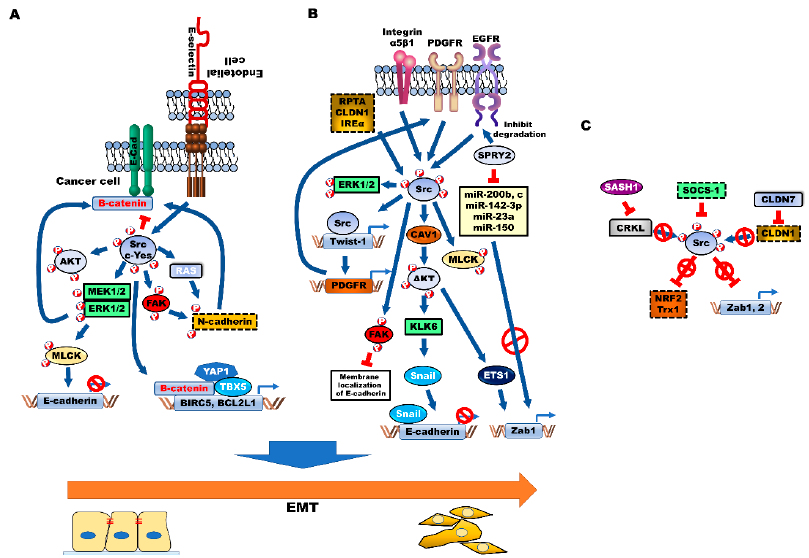
Figure 3. Src activation enhances aggressiveness, chemoresistance and acquisition of cancer stem cell (CSC) properties of colorectal cancer (CRC) by inducing epithelial-to-mesenchymal transition (EMT). Src family kinase (SFK) ( A ) and several cellular processes, such as Src activator ( B )-mediated activation of AKT, MAPK/ERK and FAK, promote EMT by downregulating E-cadherin and inducing β -catenin-dependent malignant processes and N-cadherin expression, through induction of EMT- associated transcriptional factors, such as Twist-1, Snail and Zab1. ( C ) SOCS-1 inhibits EMT through the induction of NRF2 and Trx1 by inhibiting Src. Additionally, CLDN7-mediated inhibition of CLDN1 and SASH1-mediated inhibition of CRKL suppress Src activation and inhibit EMT. ERK/MAP kinase and its direct substrate, myosin light chain kinase (MLCK), which are downstream targets of Src, are required for Src-mediated EMT induction through the formation of integrin adhesion complexes. The Src SH2 and SH3 domains promote the mesenchymal-like phenotype, by upregulating the expression of vimentin and MLC, and downregulating the expression of E-cadherin [131]. E-selectin, an adhesion receptor of endothelial cells, interacts with CRC cells and promotes extravasation of CRC cells by activating MLC through E-selectin-mediated ERK activation. E-selectin-mediated ERK activation leads to the dissociation of the E-cadherin/ β - catenin complex, which is mediated by activated Src [132]. E-selectin-induced activation of DR3 triggers the activation of Src and, subsequently, the PI3K/AKT pathway. The metastatic CRC cells lead to the upregulation of the DR3 splice variant with no death domain, which cannot trigger apoptosis. This indicates that the CRC cells shift the functional role of DR3 toward survival [133].